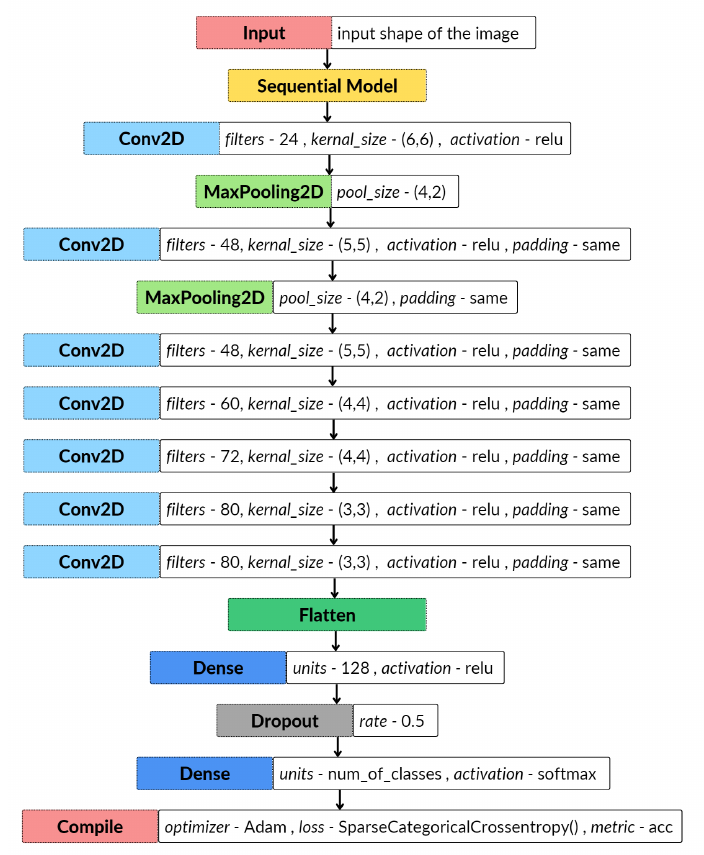
Figure 9. The CNN based architecture of the